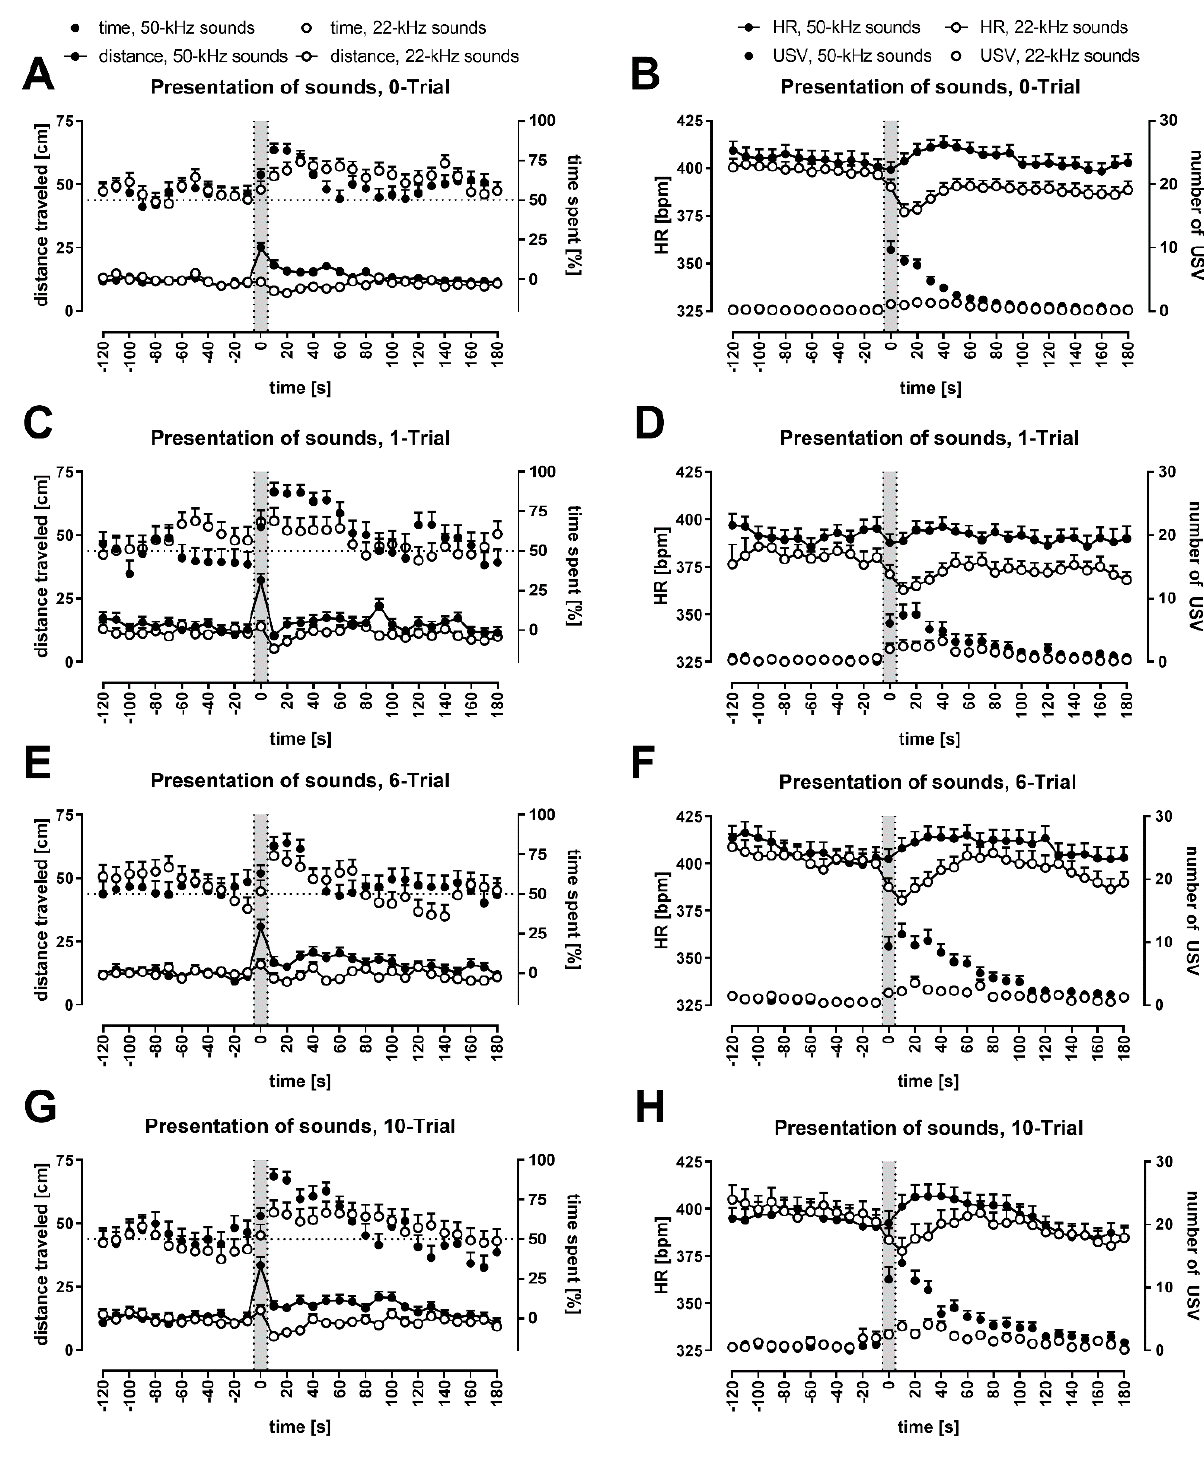
Figure 1. Analysis of changes in distance traveled, time spent in the speaker’s half of the cage, heart rate (HR), and the number of emitted vocalizations during playback session in rats exposed to both 50-kHz- vs. 22-kHz playback, with averaged effects of natural and artificial sounds. Gray sections correspond to the 10-s-long ultrasonic presentation. Graphs depict responses after previous exposure to: no shock ( A , B ), one shock ( C , D ), six shocks ( E , F ), and ten shocks ( G , H ). In the left column ( A , C , E , G ), distance traveled is presented as connected dots (cm, left Y axis), percentage of time spent in the speaker’s cage half—as not connected dots (%, right Y axis). In the right column ( B , D , F , H ), HR is presented as connected.dots (bpm; beats per minute, left Y axis); the number of USV is presented as not connected dots (right Y